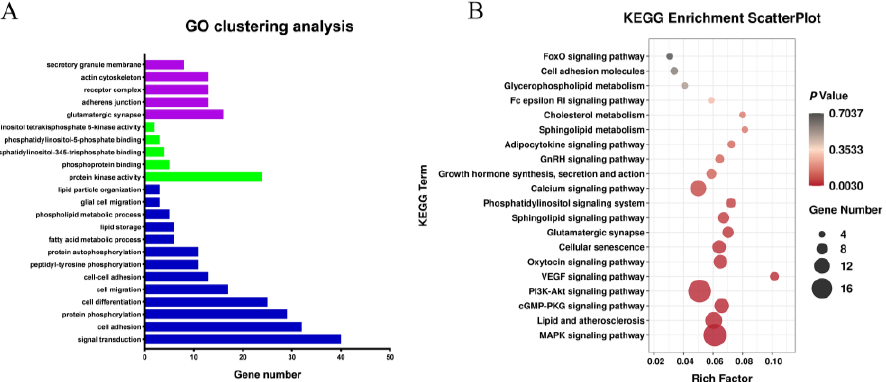
Figure 3. Analysis of Gene Ontology and KEGG Pathway Enrichment of differential mRNAs. Note: ( A ) Gene Ontology of differential mRNAs. Blue column represents BP, red column represents CC and green column represents MF; ( B ) KEGG Pathway Enrichment of differential